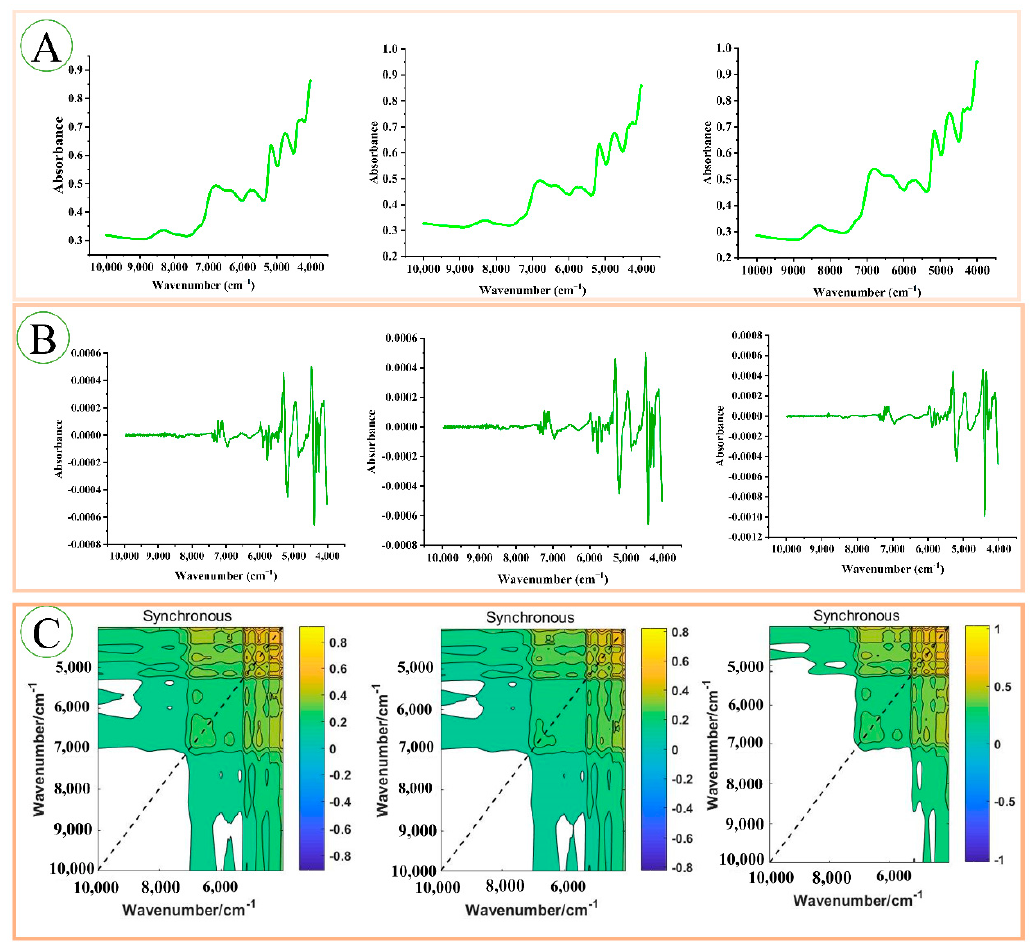
Figure 7. There are 3 data inputs for the ResNet model. ( A ) are the original FT-NIR images, ( B ) are the MSC and 2D preprocessed spectral images, and ( C ) are the Synchronous 2DCOS images.